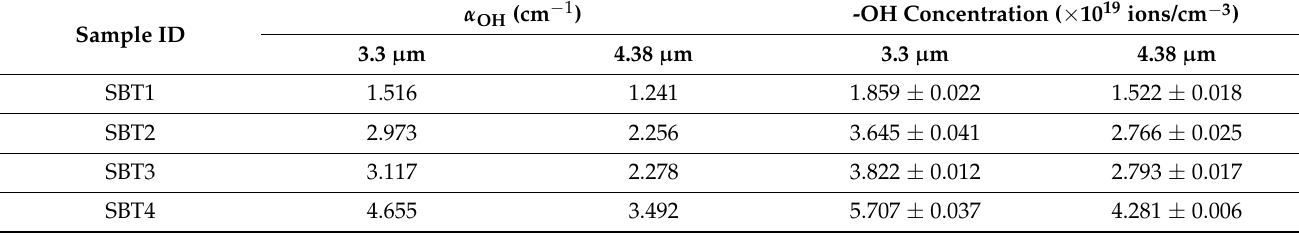
Table 2. -OH absorption coefficient, α OH (cm − 1 ), and concentration, N (cid:3016)(cid:3009) (cid:3127) (ions/cm (cid:2879)(cid:2871) ) , at mid-infrared wavelengths of 3.3 and 4.38 μ m.